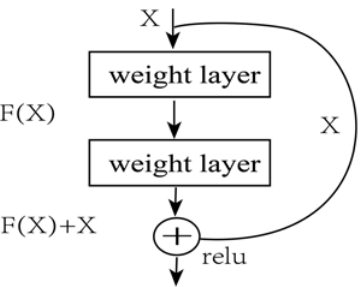
Figure 2. Residual network block structure.